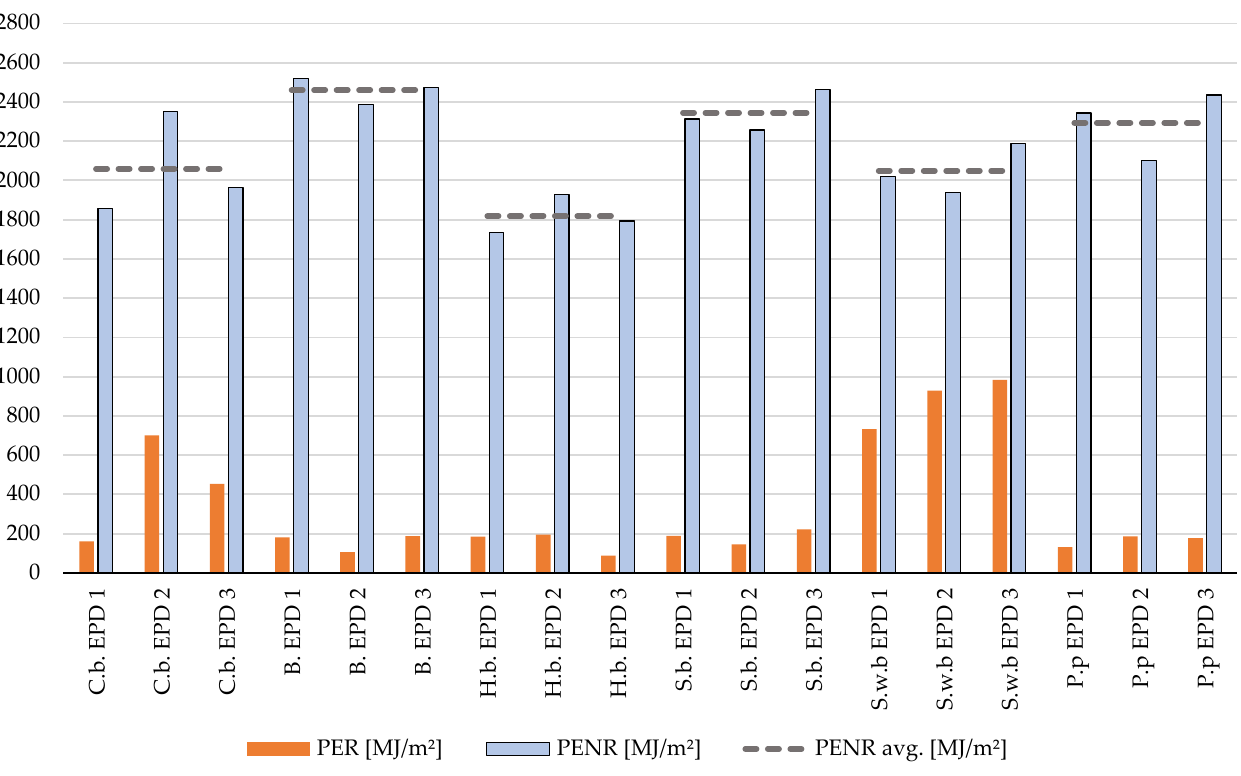
Figure 11. PENR A1–A3|LC and PER A1–A3|LC for each wall model considered. (C.b. = Concrete block; B. = Bricks; H.b. = Hollow bricks; S.b. = Sandstone bricks; S.w.b. = Shuttering wood chips blocks; P.p =Prefabricate concrete panels).